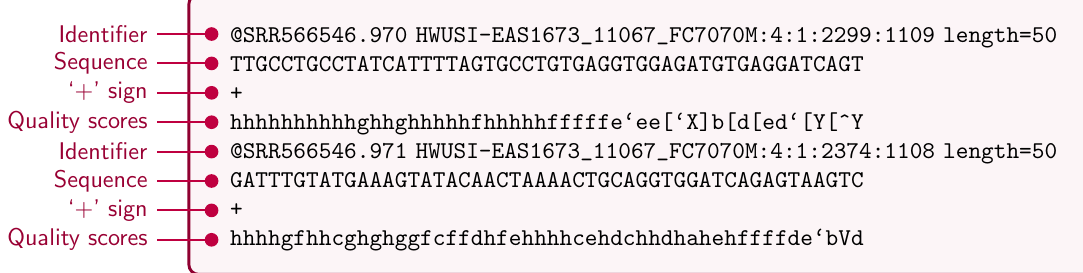
Figure 2. A sample of the FASTQ